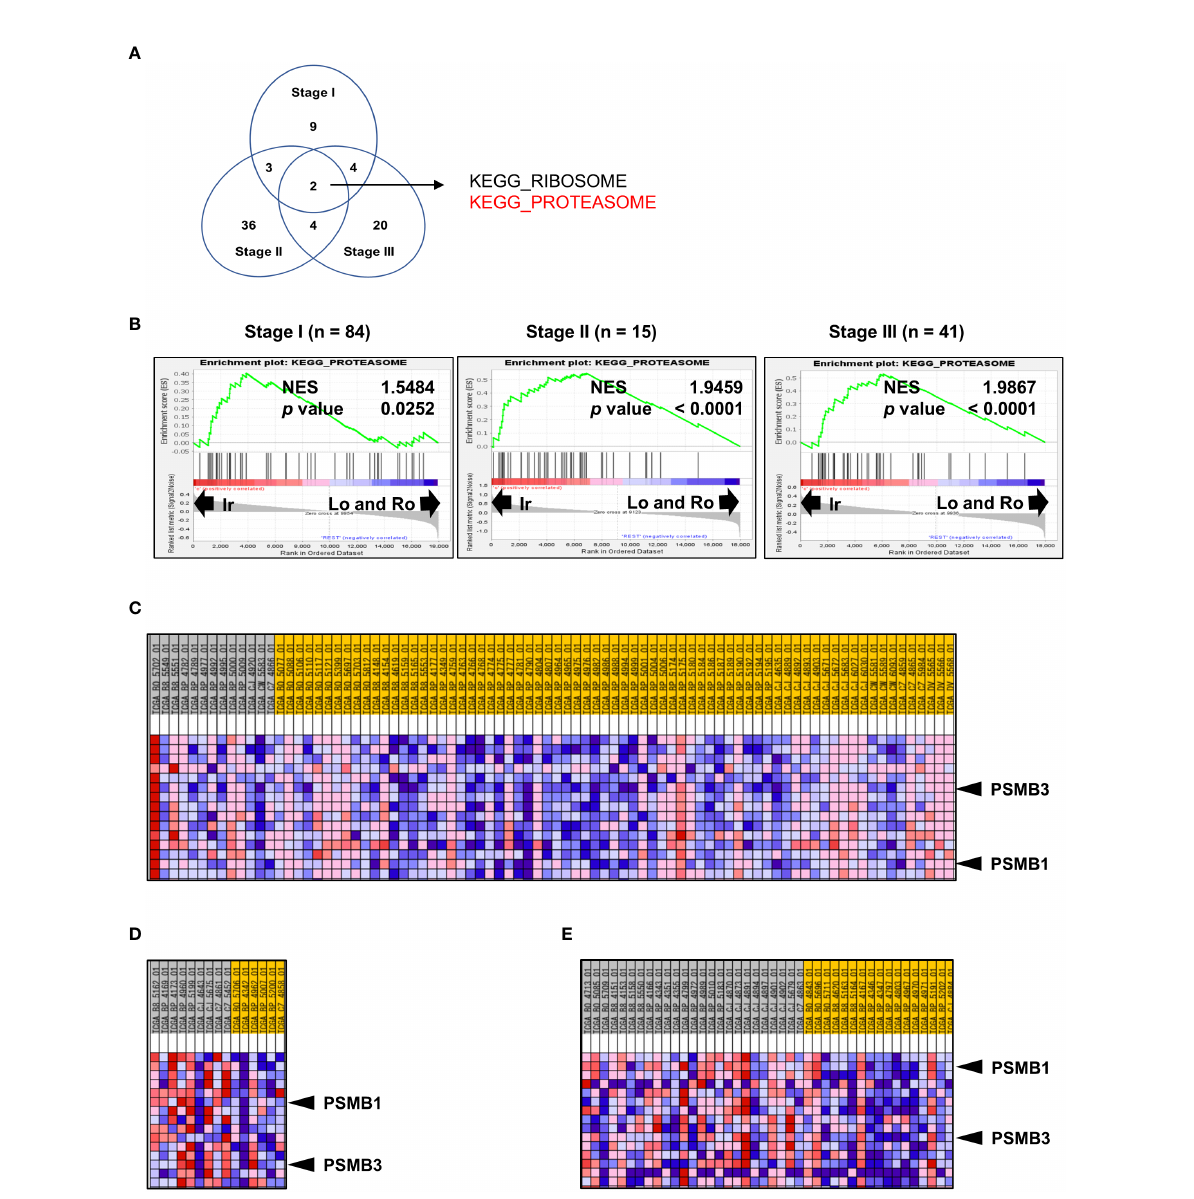
FIGURE 3 Genomic pro fi le comparison between irregular type and the others. (A, B) Comparison of the irregular type with the other RM types for ccRCC stages I, II, and III using GSEA. (A) Venn diagram showing the number of KEGG gene sets that were signi fi cantly positively enriched in the irregular type. (B) Normalized enrichment score (NES) of “ KEGG PROTEASOME ” at each stage. (C – E) Blue-Pink O ’ Gram of the gene set “ KEGG PROTEASOME ” was limited to the top 15 genes whose expression was strongly biased toward the irregular type of stage I (C) , stage II (D) , and stage III. (E) Only PSMB1 and PSMB3 (two non-catalytic components of the 20S core proteasome complex) were common in all